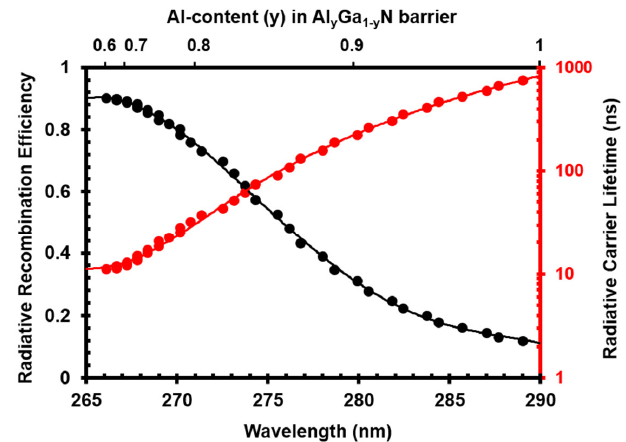
Figure5. Radiativerecombinationefficiency(black)andradiativecarrierlifetime(red)fromaAl 0.5 Ga 0.5 N- Figure 5. Radiative recombination efficiency (black) and radiative carrier lifetime (red) from a delta-GaN QW with di ff erent barrier Al content; the delta-GaN layer thickness is fixed at 3 Al 0.5 Ga 0.5 N-delta-GaN QW with different barrier Al content; the delta-GaN layer thickness is fixed at